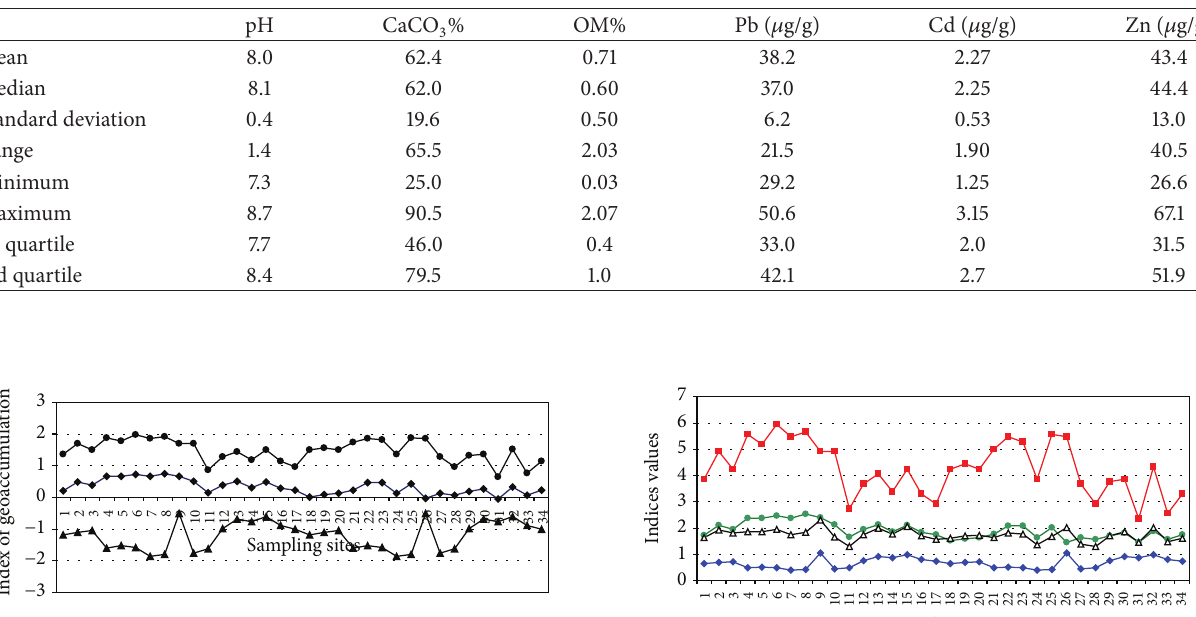
Table 2: Summary statistics of the analyzed soil samples results.